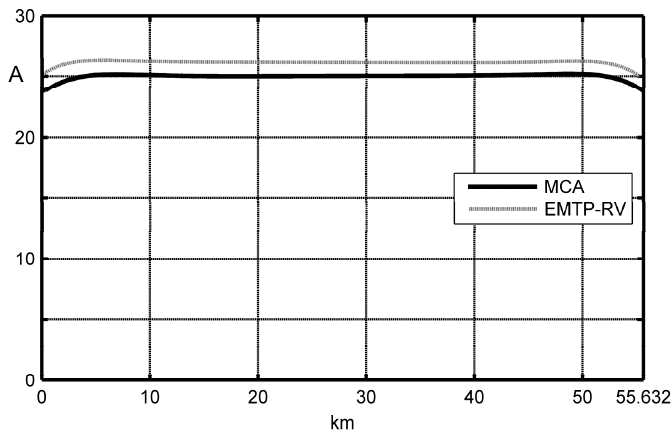
Figure 13. Steady state ground return current magnitude comparison between the MCA and EMTP-RV.